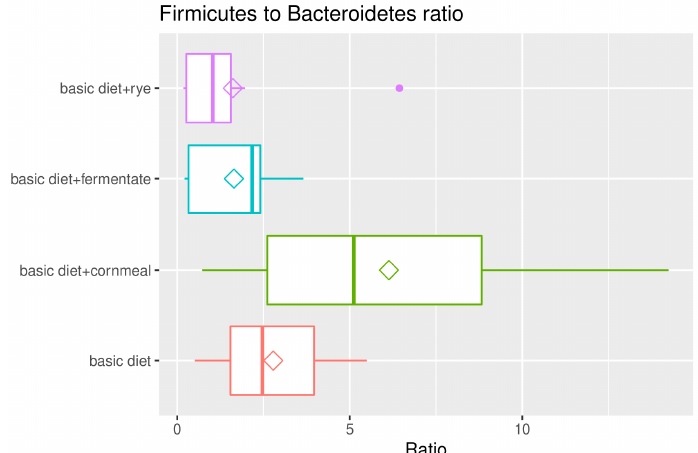
Table 3. Relative abundance (mean ± s.d., in %) of bacterial phyla > 1% and Firmicutes/Bacteroidetes ratio ( F / B ratio, median) in faecal samples of dogs fed the vegetarian diet (basic diet) or the vegetarian diet supplemented with feather meal as well as either cornmeal (basic diet + cornmeal), fermented rye (basic diet + fermentate) or rye (basic diet + rye).